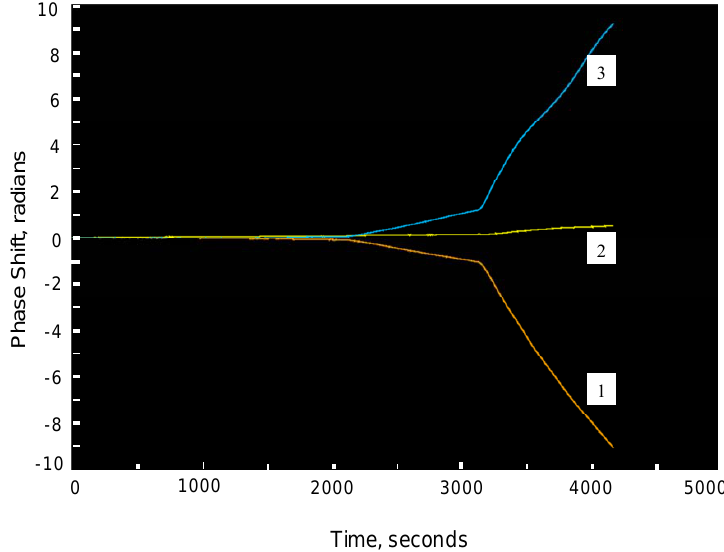
Figure 9. Multichannel interferometer response with exposure to water solution containing E. coli O1: H57 at ~ 10 7